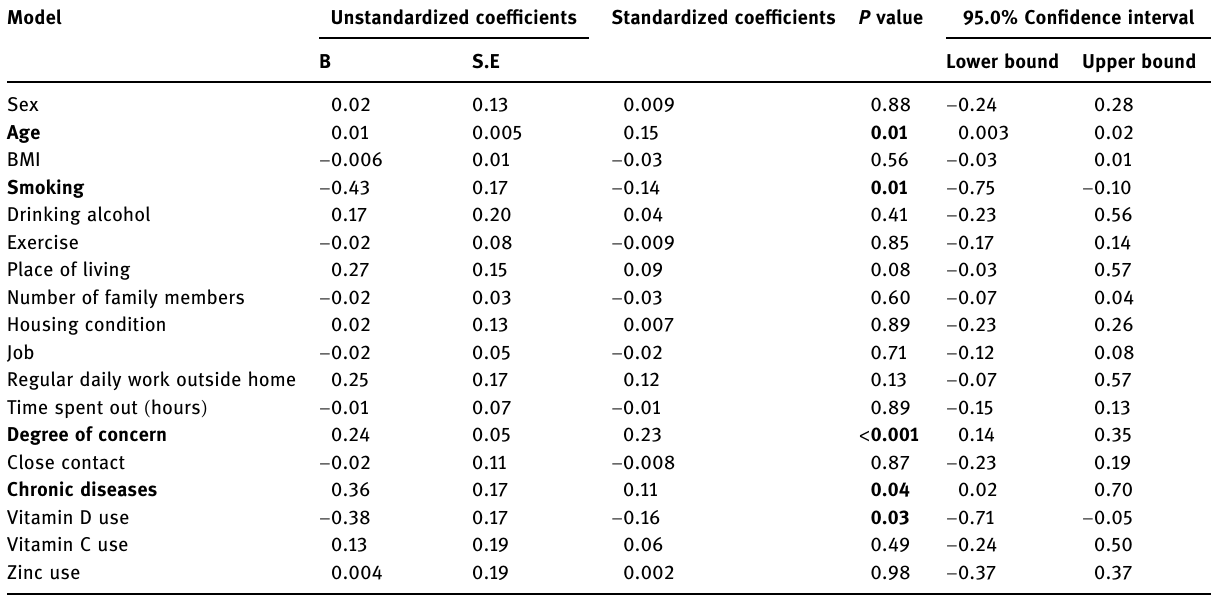
Table 4: Socio - demographic parameters and prophylactic dietary supplements as predictors of COVID - 19 severity through multiple linear regression analysis